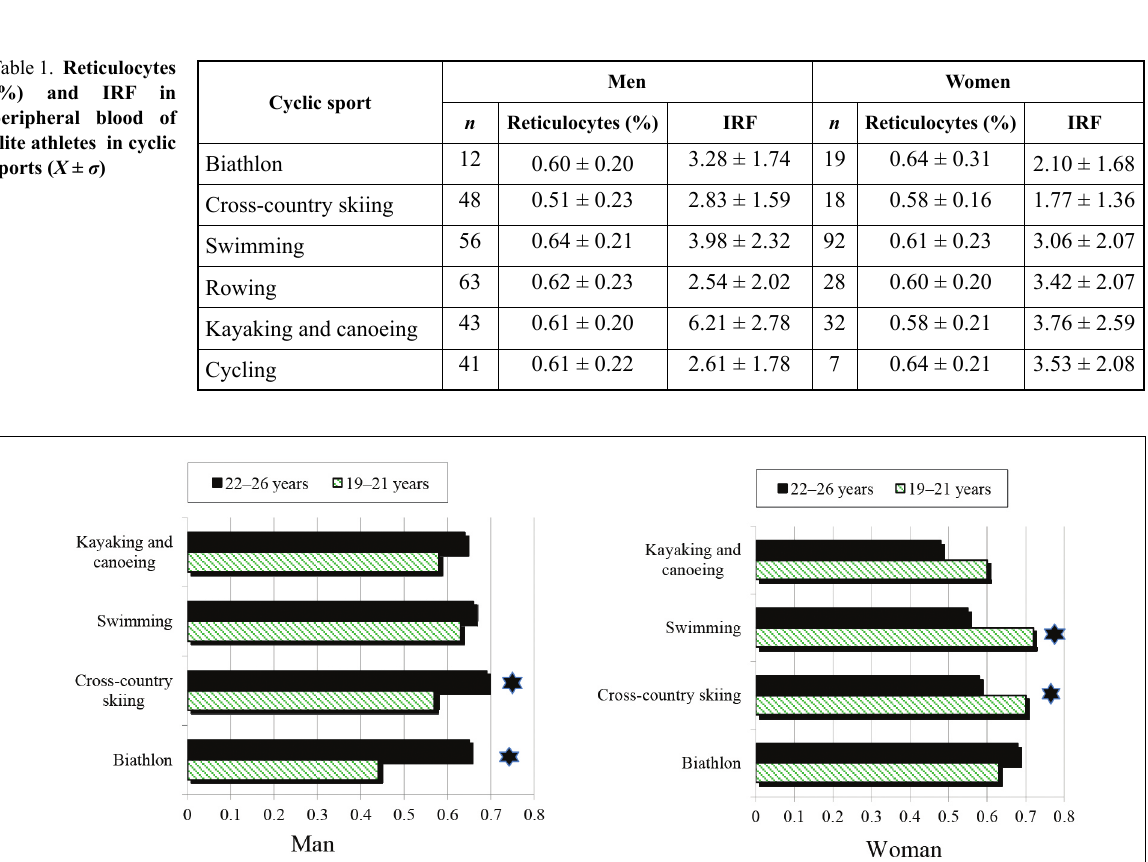
Figure 1. The mean group data of reticulocytes in cyclic sports athletes in the aspect of age and